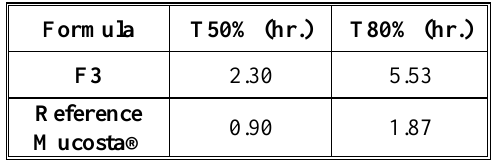
Table (7) Drug release parameters from the insert F3 and mucosta® suspension